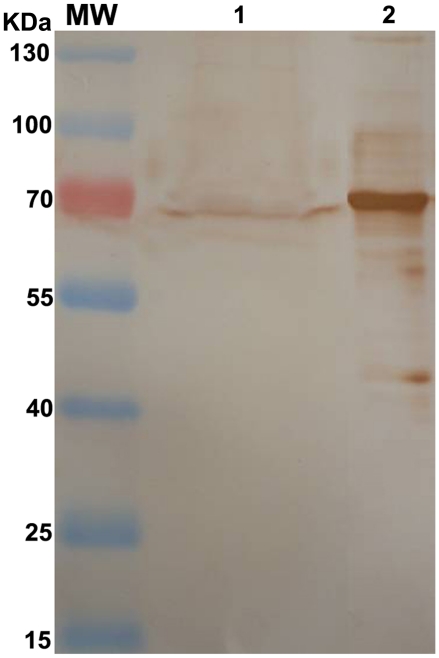
Western blotting analysis of S. japonicum worm homogenate.Adult worm supernatant (lane 1) and purified recombinant SjTGR protein (lane 2) detected by mice polyclonal serum antibodies against recombinant SjTGR. MW: Protein molecular weight marker.